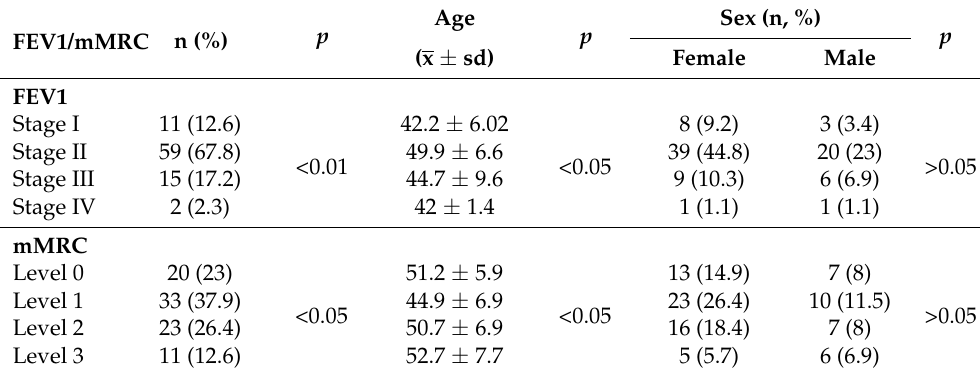
Table 1. The general characteristics of patients at different stages of COPD.